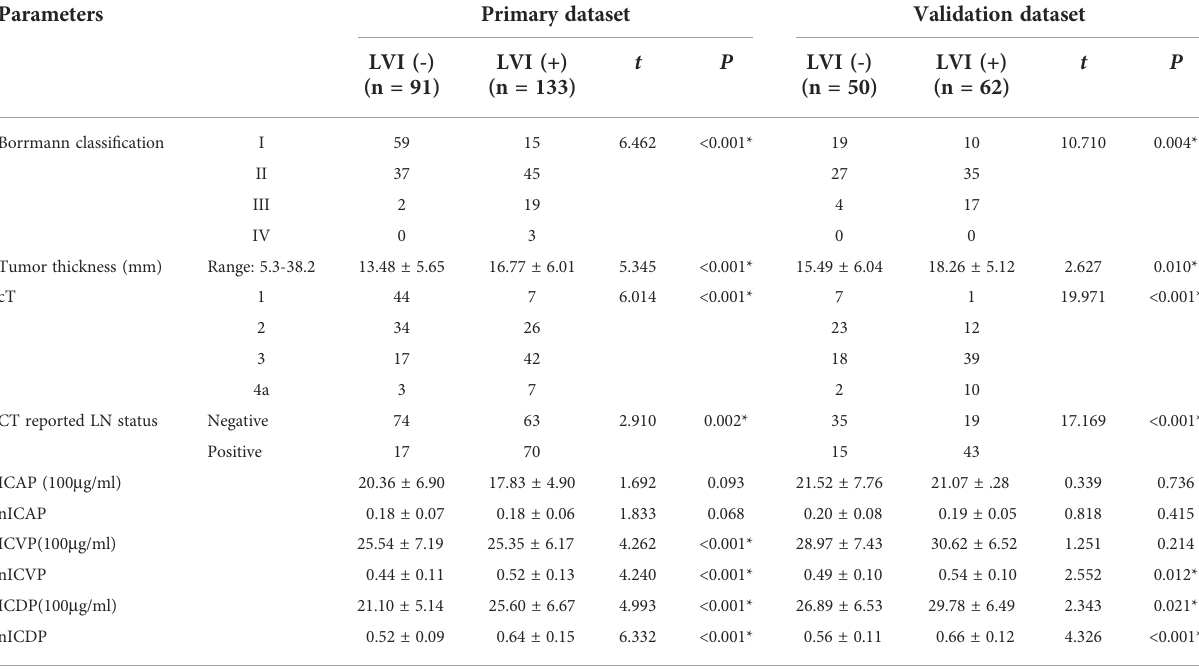
TABLE 3 Comparison of CT parameters between LVI positive and negative group in the primary and validation datasets. Parameters